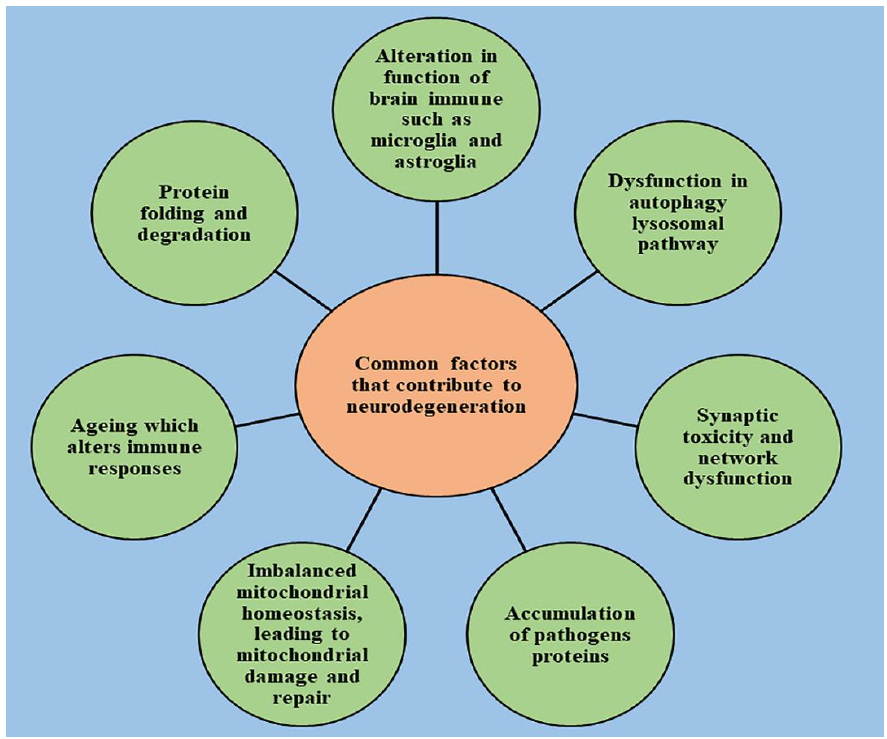
Figure 1. Some of the common factors responsible for the initiation / progression of neurological